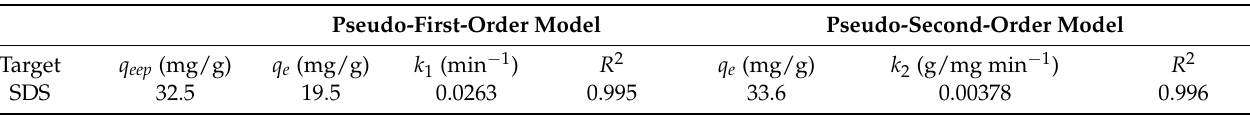
Table 2. Isotherm parameters of SDS adsorption by the modified cellulose. Pseudo-First-Order